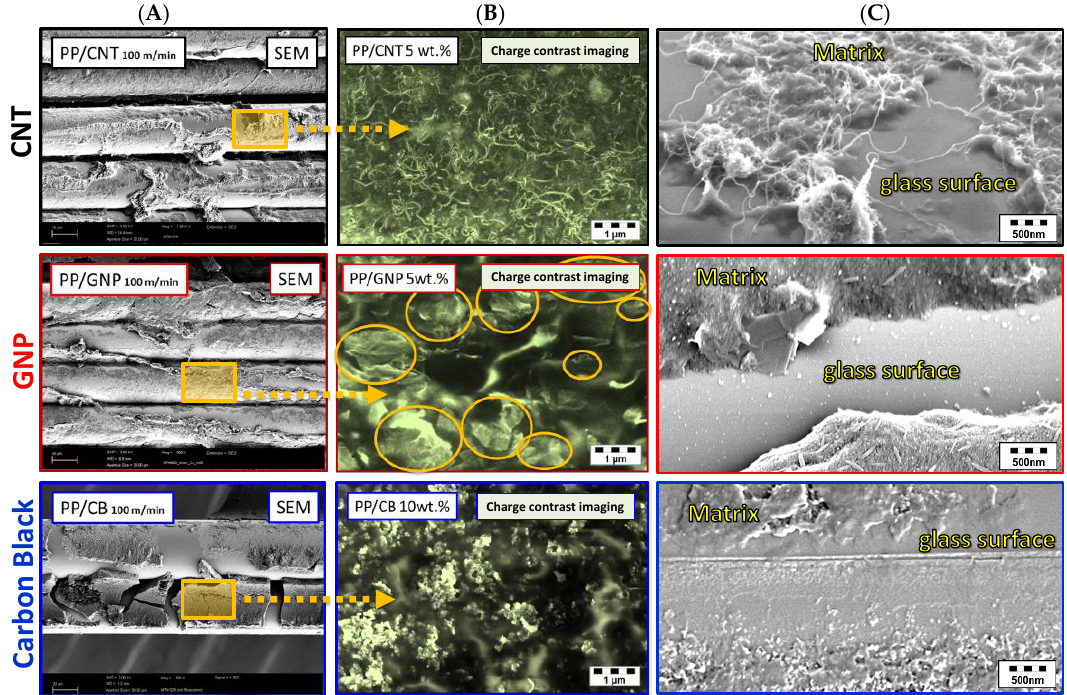
Figure 5. SEM pictures of nanostructured glass fibre bundles (drawing velocity 100 m/min) using 5